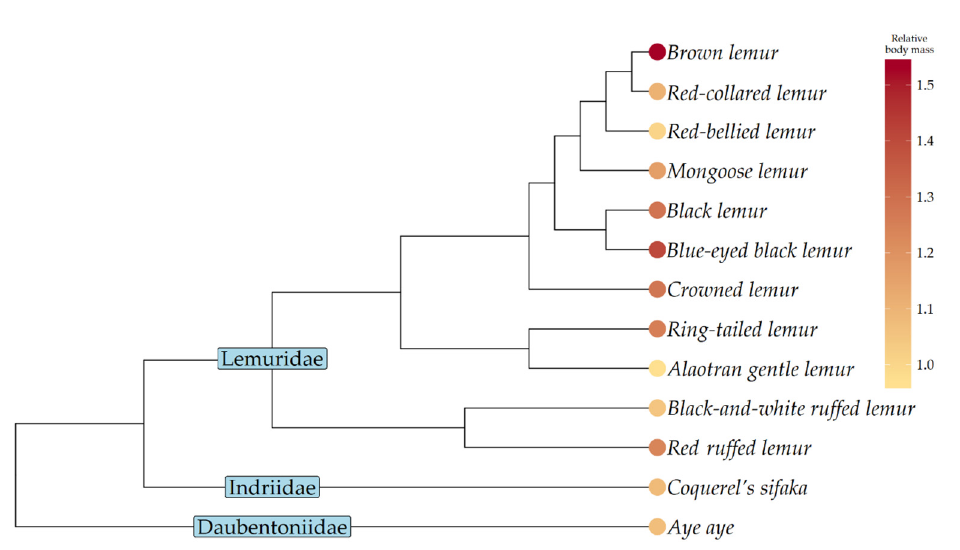
Figure 2. Box-and-whisker plots of relative body mass values of individual adult lemurs, from the 13 species featuring in our comparative analyses. Ring-tailed lemurs, mongoose lemurs, black-and-white ruffed lemurs, and red ruffed lemurs also featured in our epidemiological analyses. Sample sizes are shown in parenthesis next to species’ names, and are also are indicated by the relative width of their respective boxplot. Species’ medians are indicated by vertical lines on the boxes; the extent of the boxes indicate their interquartile ranges; whiskers represent values within 1.5 times the interquartile range; and outliers outside this are depicted as points. The healthy range (0.75–1.25) is shown by yellow shading; overweight by orange (1.25–1.5); obese by red (1.5–2); and morbidly obese (>2) by the darker red.